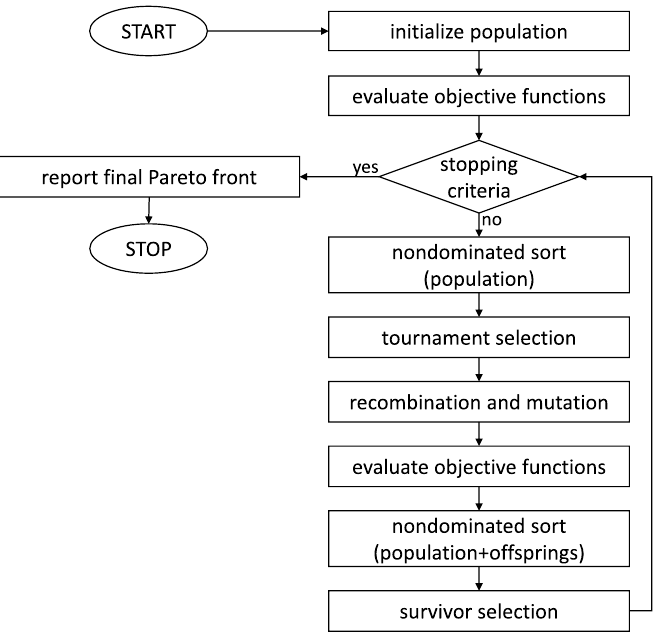
Figure 1. Flowchart of computations: NSGA-II algorithm [38] applied to the trajectory identifica- tion